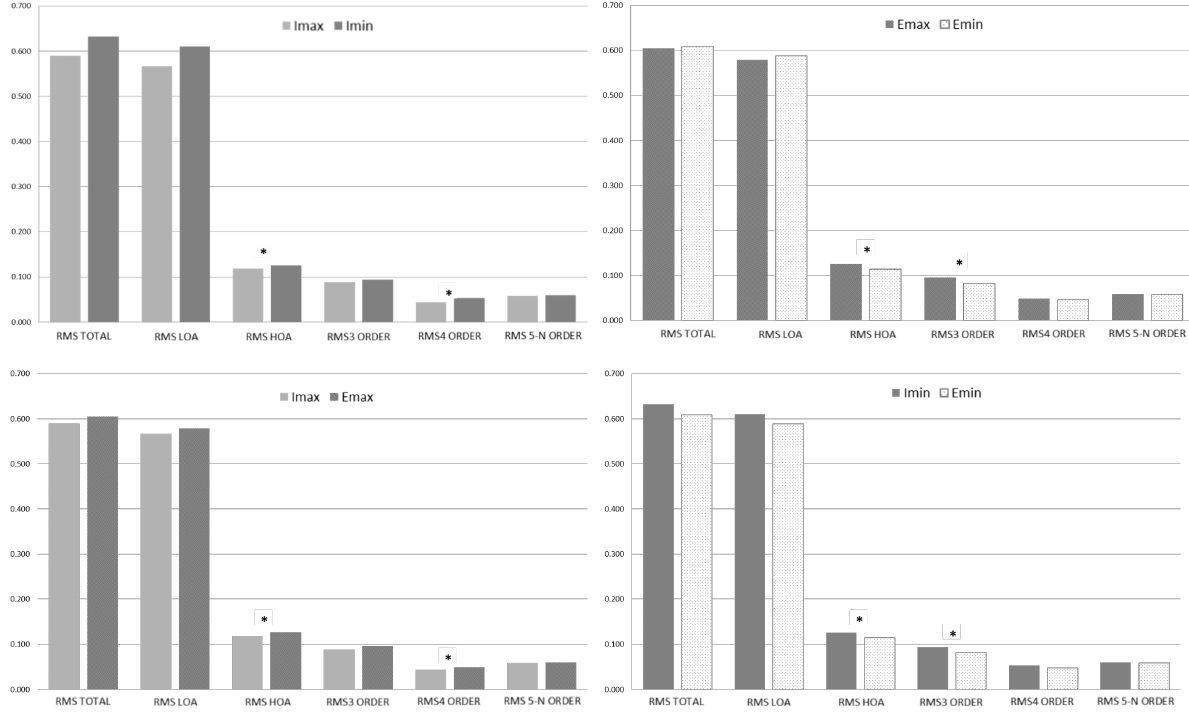
Figure 5. Comparison of the RMS (µm) of aberration measured after reading with e-ink reader and iPad in maximum and minimum lighting conditions. The asterisk indicates statistically significant differences (p<0.05). The iPad with maximum lighting conditions (Imax) in light grey, iPad with minimum lighting conditions (Imin) in dark grey, Ebook with maximum lighting conditions (Emax) in dark dotted, Ebook with minimum lighting conditions (Emin) in light